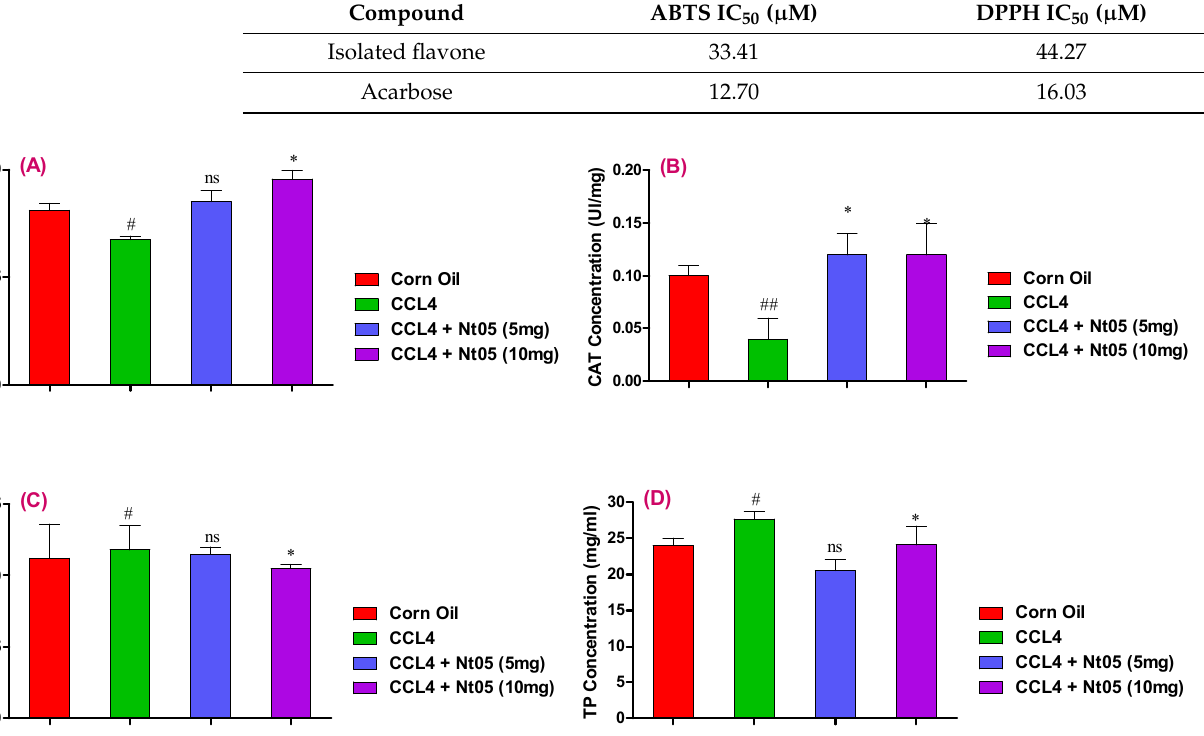
presented as mean ± SD; n = 5; significant difference: Corn oil compared to the CCl4 group— Figure 3. The exhibited ( A ) SOD, ( B ) CAT, ( C ) MDA and ( D ) TP concentration values. Results pre- # p < 0.05 ## p < 0.01. CCl sented as mean ± SD; (cid:1866) = 5; significant difference: Corn oil compared to the CCl4 group— # p < 0.05 4 further compared to the sample treated groups—* p < 0.05. ## p < 0.01. CCl 4 further compared to the sample treated groups—* p < 0.05. SOD: superoxide dismu- tase, CAT: catalase, MDA: malondialdehyde, TP: total proteins.